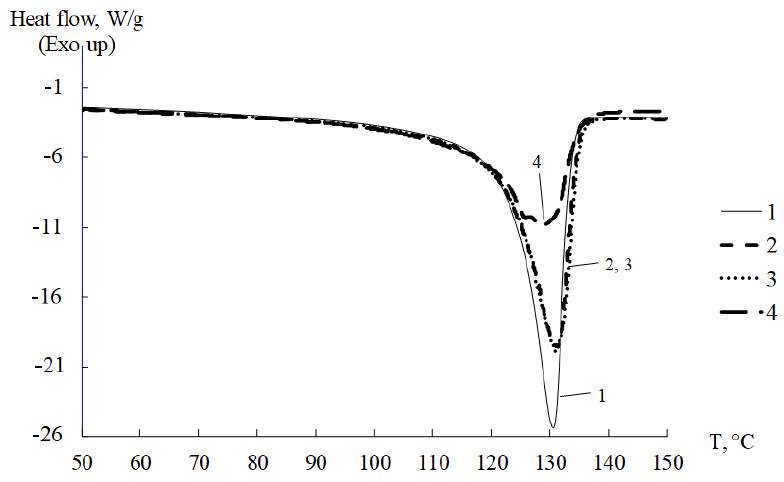
Figure 1. DSC thermograms for PE of different grades: 1—PEVP 277-73; 2—HE3490-IM; 3—CRP 100 Hostalen; 4—Stavrolen